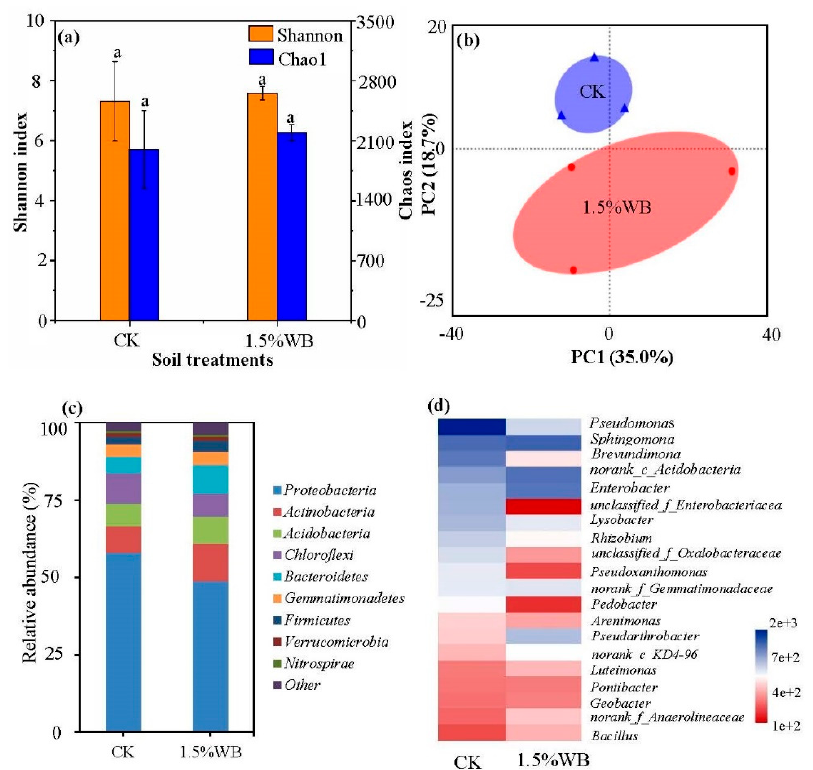
Figure 3. Effect of WB on the bacterial community in the coastal soils planted with wild soybean. The richness (Chao1) and diversity (Shannon) index for the soil bacterial community ( a ). Principal com- ponent analysis (PCA) of bacterial community composition based on the Bray-Curtis similarity ( b ). Relative abundance of the top 10 bacterial phyla ( c ). Heat map of the top 20 bacterial genera ( d ). CK: soil treatment without WB amendment; 1.5% WB: soil amended with WB at the rate of 1.5% ( w / w ). Different small letters on the bars indicate significant difference between different treatments (Tukey’s HSD test, n = 3, p <